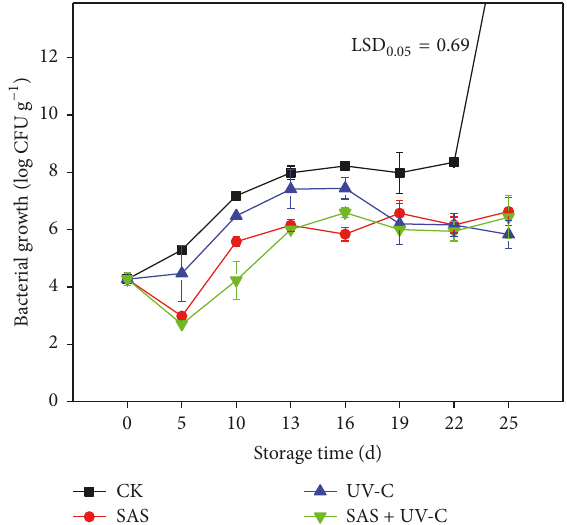
Figure 5: Effects of SAS, UV-C, and SAS + UV-C on APC of fresh- cut potatoes during storage. The error bars represent the standard deviation. LSDs represent least significant differences at the 0.05 level.